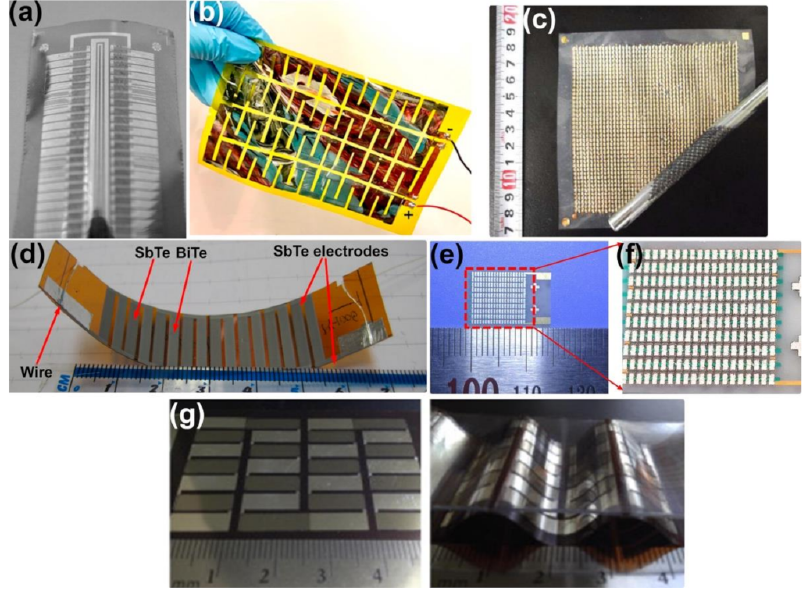
Figure 2. Thin film flexible TE devices. ( a ) Screen printed Sb 2 Te 3 /Bi 2 Te 3 TE legs on a flexible